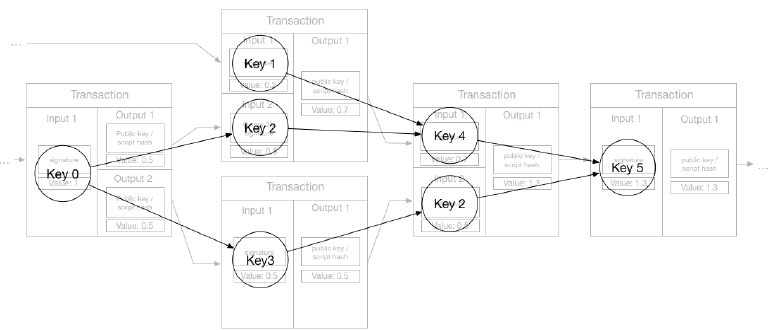
Figure 2. Transaction network with keys shown.